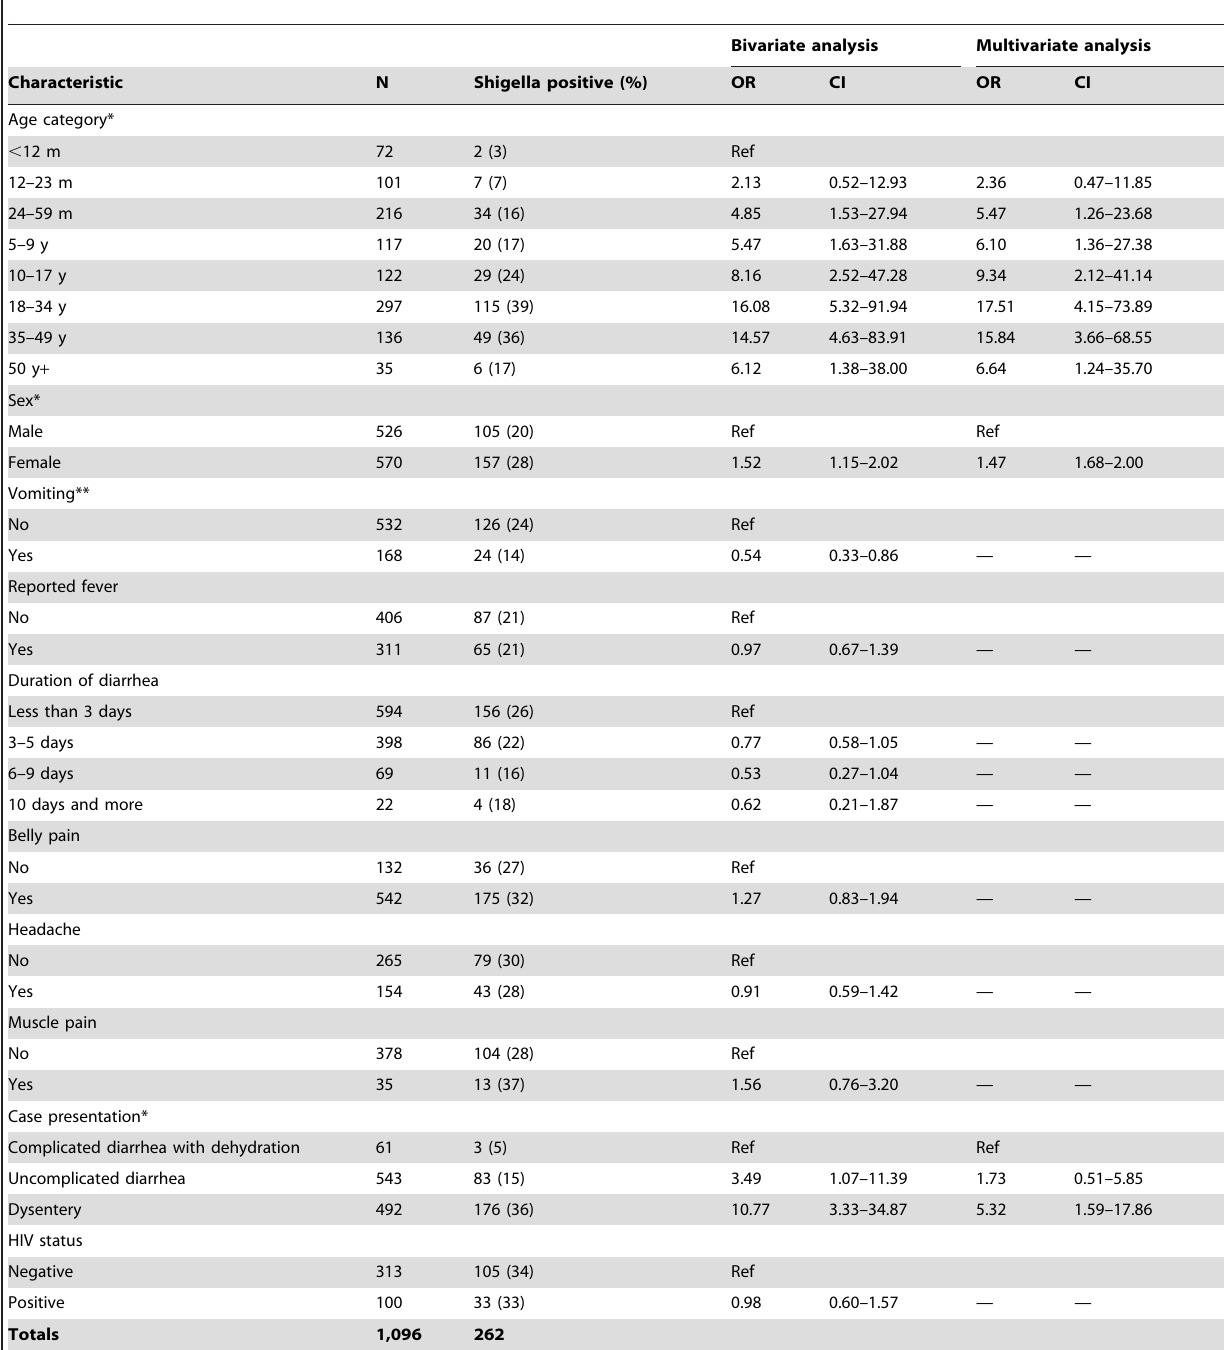
Table 2. Demographic and clinical characteristics associated with shigellosis on bivariate and multivariate analysis among patients seen in study clinic, 1 st Jan 2007 to 31 st Dec 2011, Kibera.